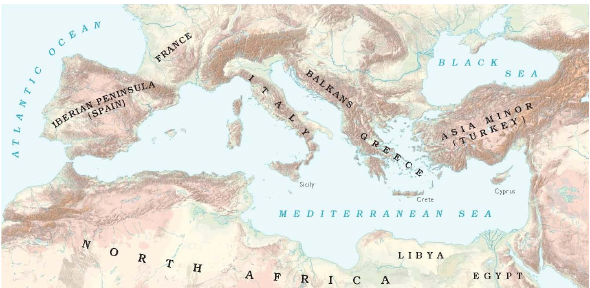
Fig. 1. A map of the Mediterranean region. This material orig- inated on the Interactive Ancient Mediterranean Web site (http: //iam.classics.unc.edu). It has been copied, reused or redistributed under the terms of IAM’s fair use policy. Copyright 1998, Interac- tive Ancient